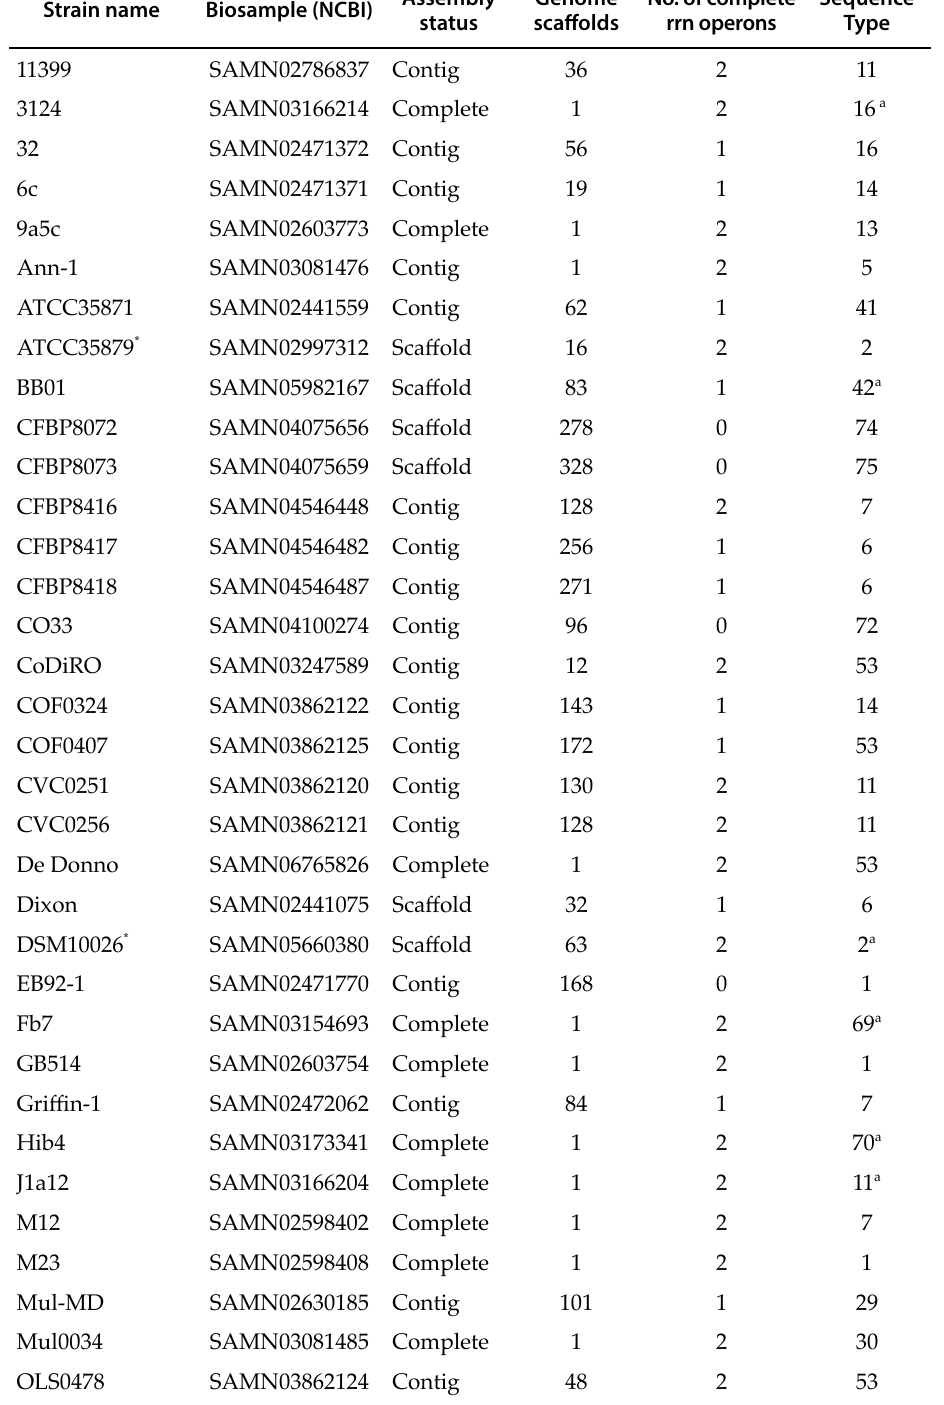
Table 4. Xylella fastidiosa genomes used in this study